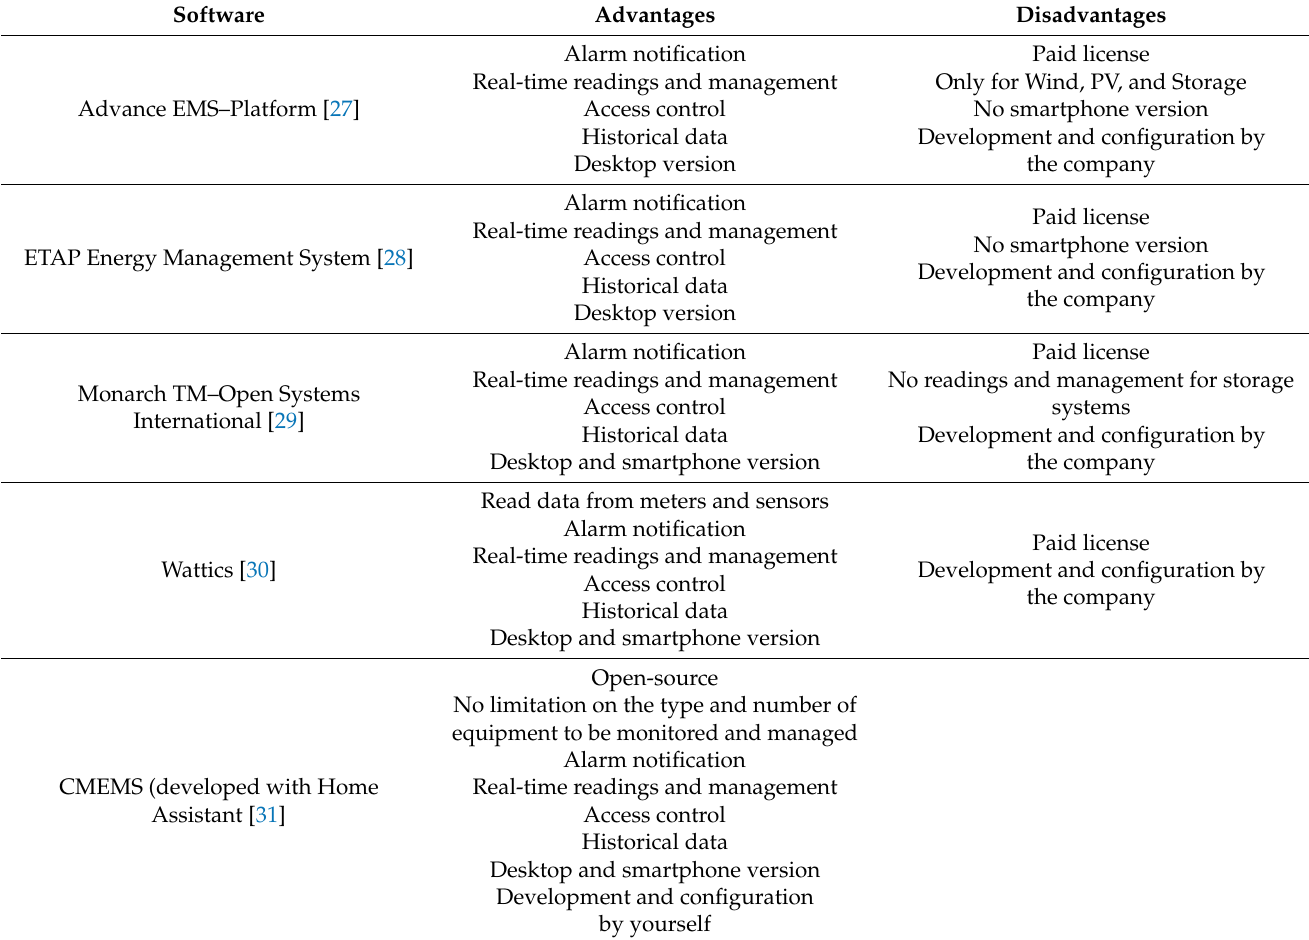
Table 1. Advantages and disadvantages of different software. Source: prepared by the authors from various documents [22–26]. Own